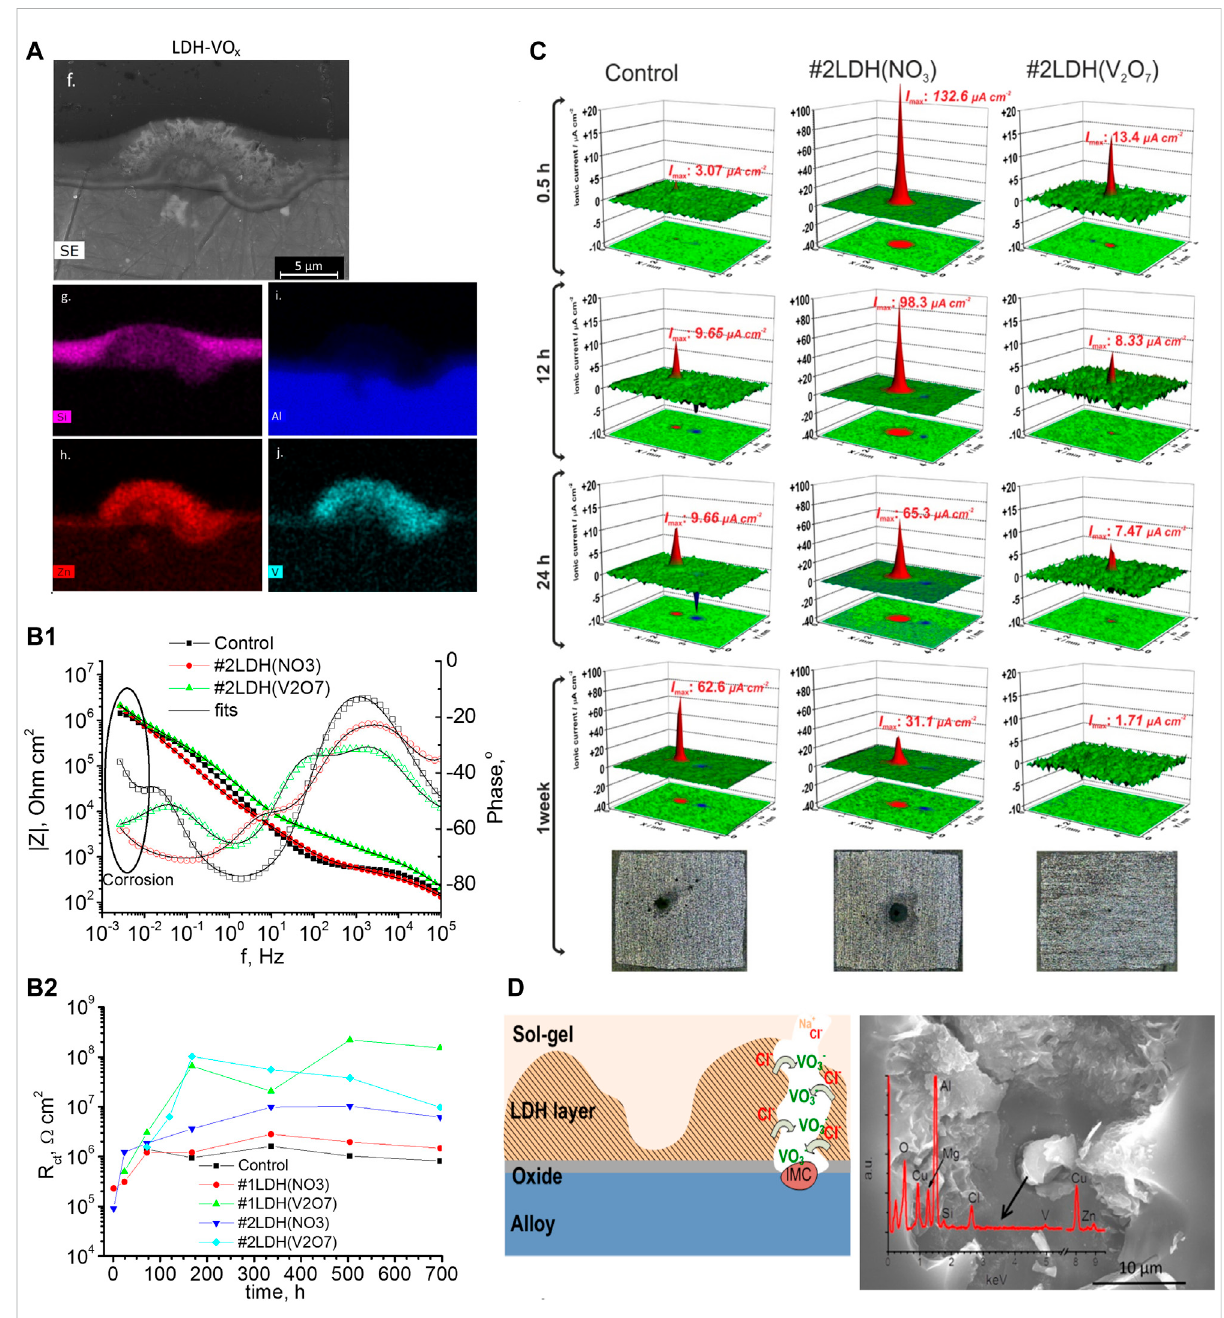
FIGURE 9 (A) SEM micrographs and EDS elemental maps of #1LDH-V 2 O 7 cross-section; (B1) EIS spectra of Control, #1LDH-NO 3 and #1LDH-V 2 O 7 coatings after 14 days immersionin0.5 MNaClsolution; (B2) evolutionofcharge transferresistance R ct parameter during immersion; (C)